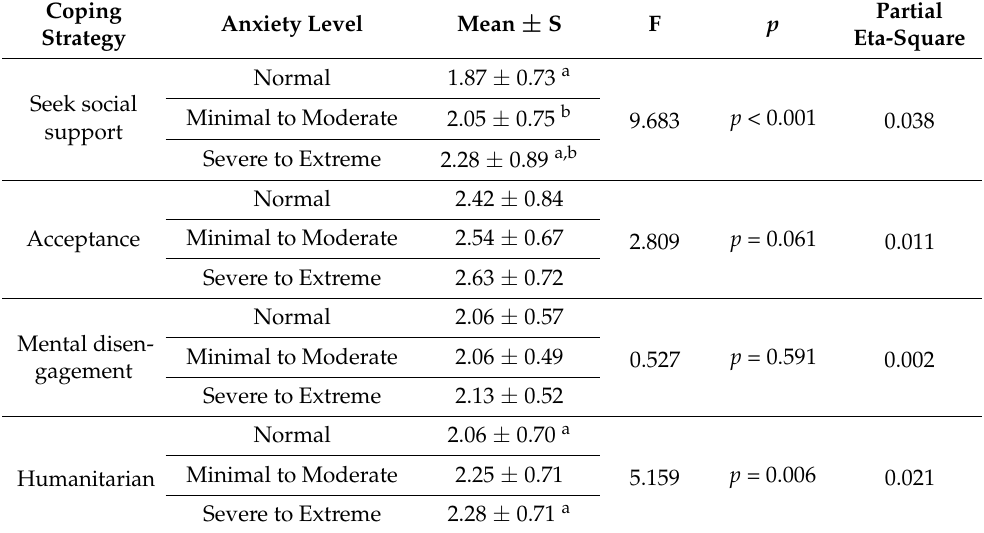
Table 3. Anxiety level and coping